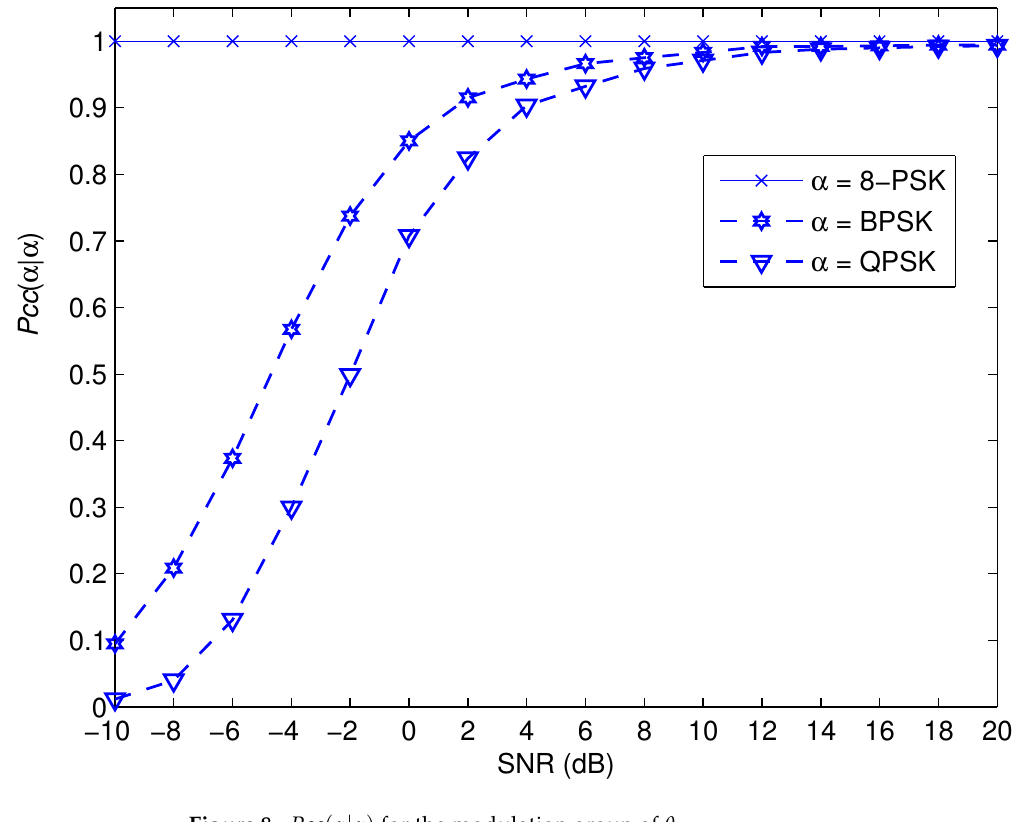
Figure 8. Pcc ( α | α ) for the modulation group of θ 2 .